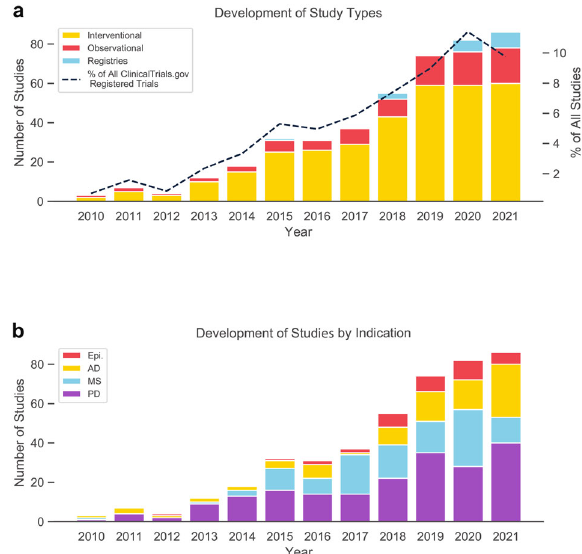
Fig. 1 Development of clinical trials for chronic neurological diseases by year of initiation, trial type and indication. a Number of analyzed studies using Digital Health Technologies (DHTs) per year, strati fi ed by the type of the respective trial. Line depicts the percentage of DHT trials out of all trials for the analyzed indications starting in the respective year. b Number of analyzed studies using DHTs per year, strati fi ed by the indications epilepsy (Epi.), Alzheimer ’ s disease (AD), multiple sclerosis (MS), and Parkinson ’ s